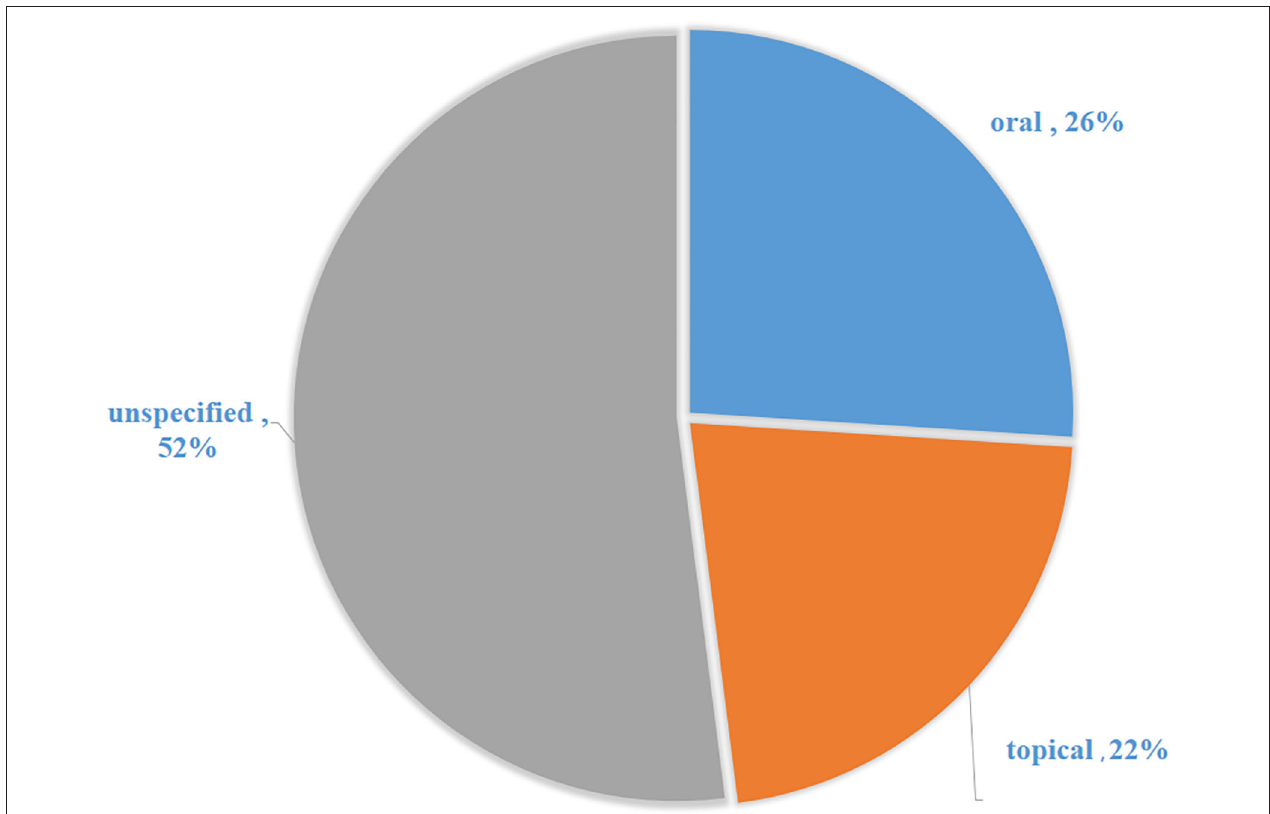
FIGURE 5 | Distribution of the mode of administration for medicinal plants used to treat cattle diseases in South